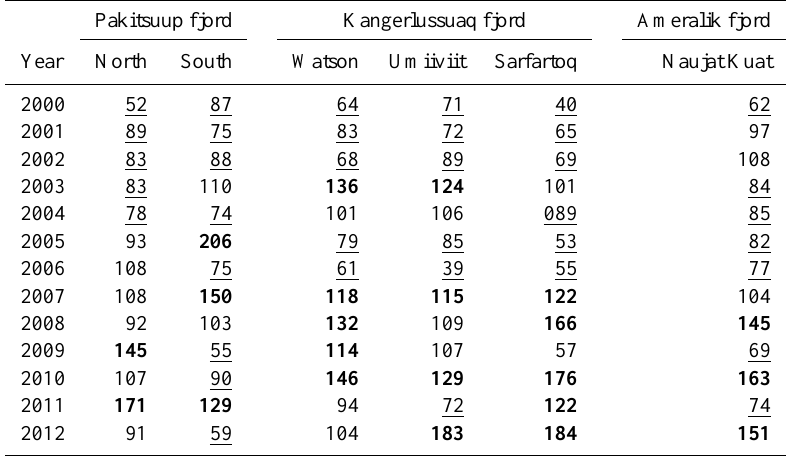
Table 5. Percent available fjord pixels in a melt season above 250mgL − 1 ( P > 250 ) as a percent of statistics’ 13 year mean. Underlined values are statistically below the mean, bold values statistically